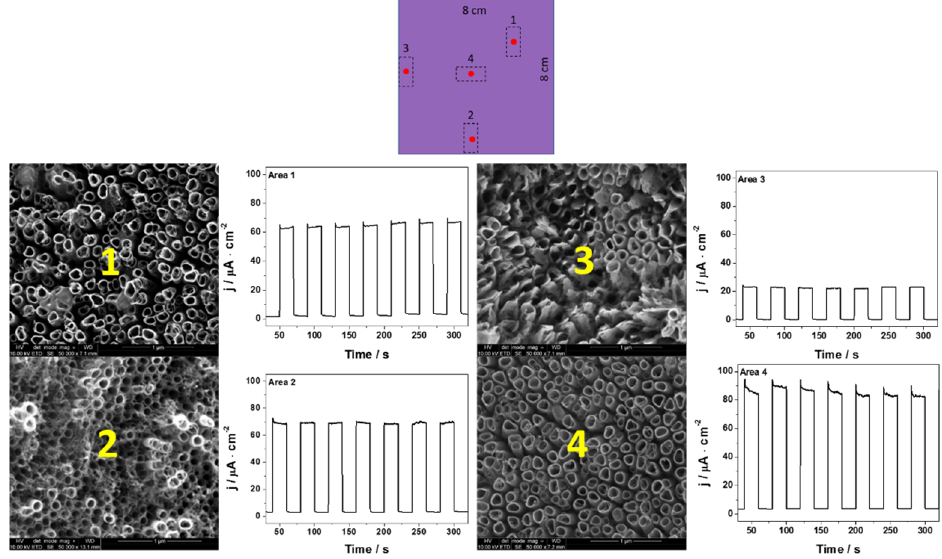
Figure 5. Transient photocurrent responses and SEM at various places on the ( a ) TN25 and ( b ) TN36.